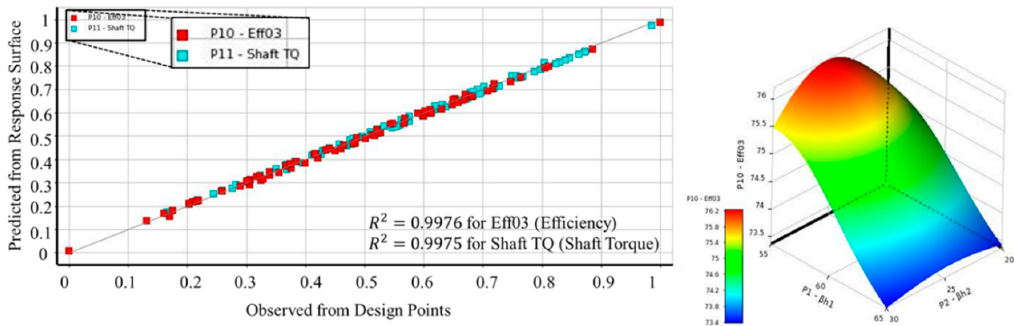
Figure 8. Goodness-of-fit of the response surface using non-parametric regression and the response surface of (cid:2010) (cid:3035),(cid:3013)(cid:3006) ( (cid:2010) (cid:3035)(cid:2869) )– (cid:2010) (cid:3035),(cid:3021)(cid:3006) ( (cid:2010) (cid:3035)(cid:2870) ) on the efficiency.